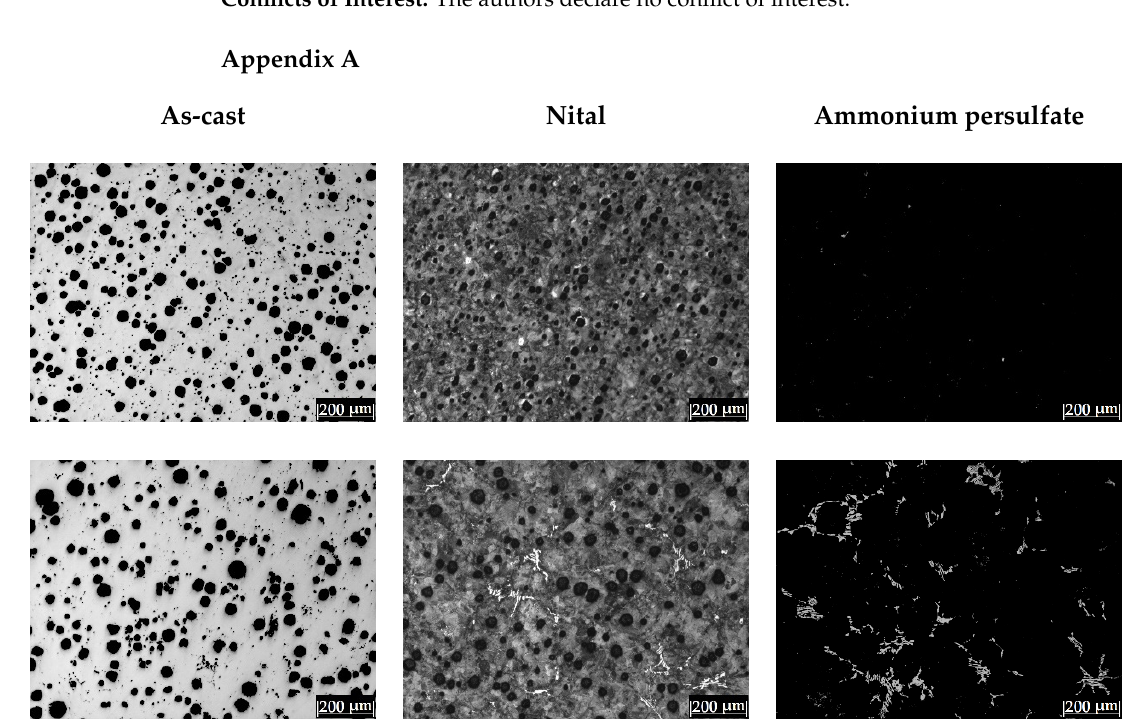
Figure A1. Microstructure of DI-0.2Cr sample for the top, middle, and bottom zones for ( a ) as-cast, ( b ) etched with nital, and ( c ) etched with ammonium persulfate conditions. Top